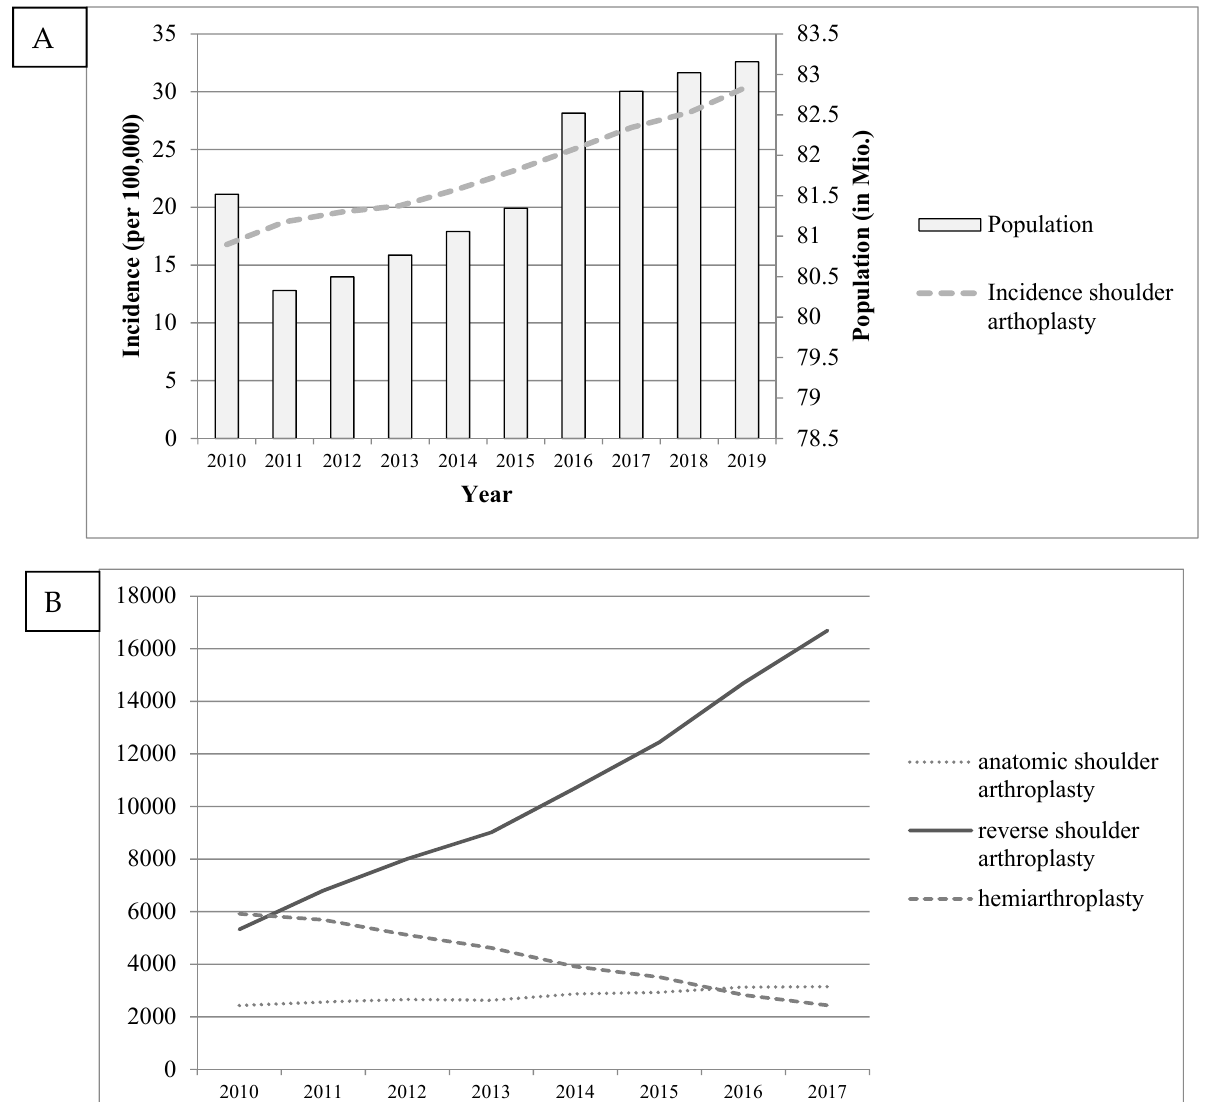
Figure 1. German population,shoulder arthroplasty incidence (A) and types of procedure (B) from 2010 to 2017.